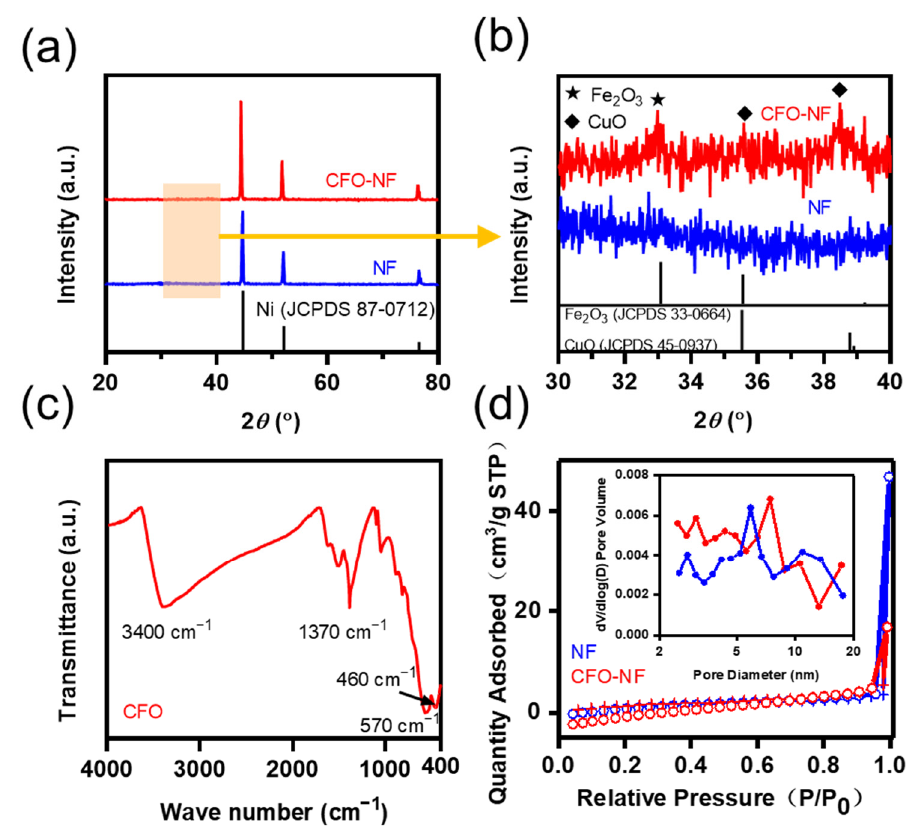
Figure 2. ( a , b ) XRD patterns of NF and CFO-NF, ( c ) FTIR spectra of CFO scratched from CFO-NF, ( d ) N 2 adsorption/desorption isotherms of NF and CFO-NF (insert: Barrett-Joyner-Halenda